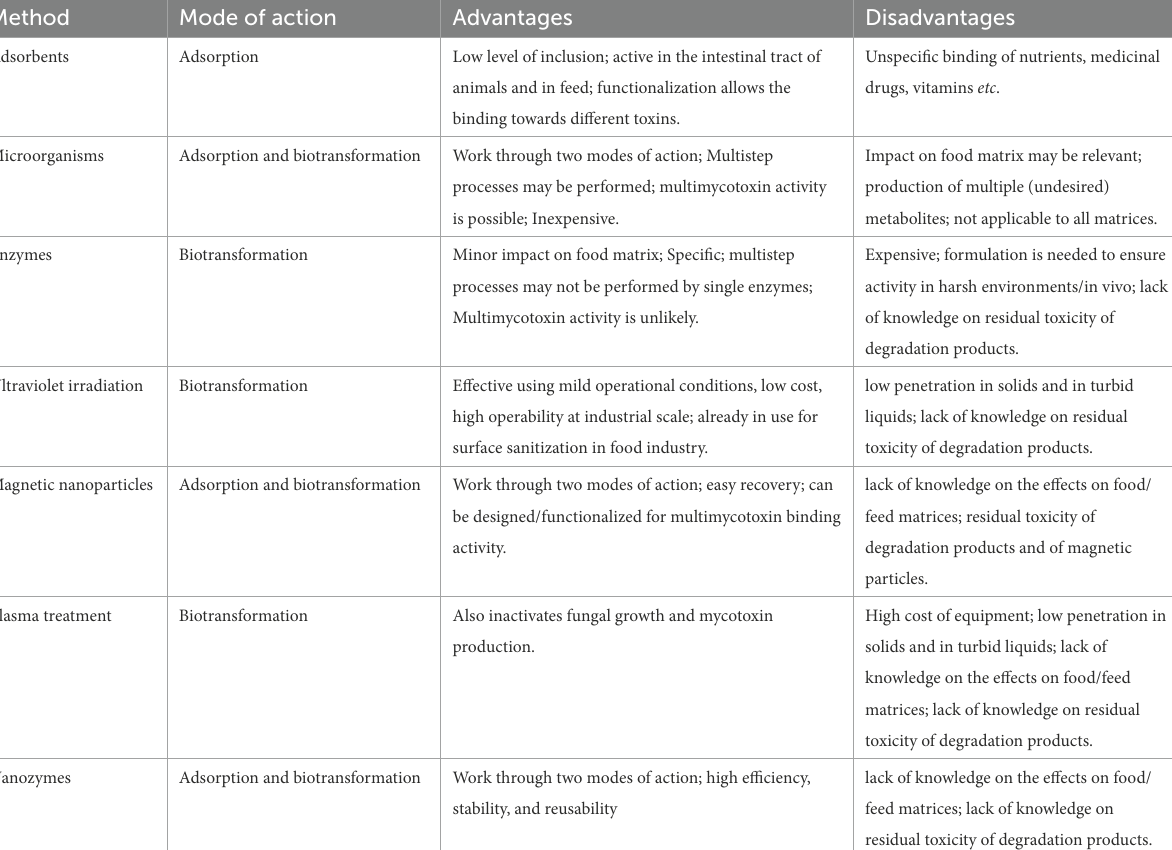
TABLE 1 Mode of action, advantages, and disadvantage of aflatoxin decontamination